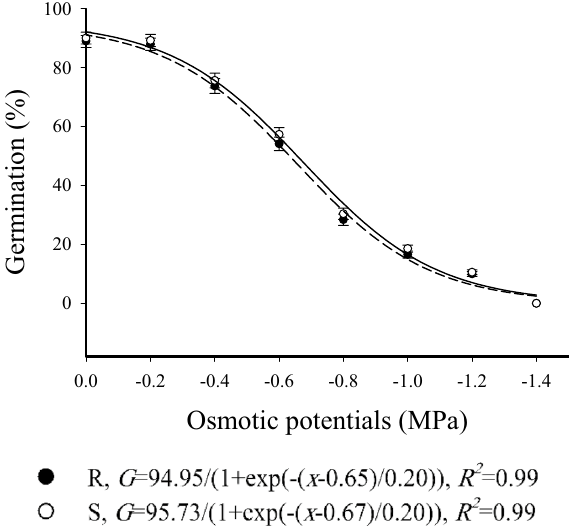
Figure 2. Germination of herbicide-resistant (black circles) and -susceptible (white circles) winter wild oat biotype as affected by different osmotic potentials. The data was fit with a three parameter sigmoidal function using SigmaPlot Version 12.5, from Systat Software, Inc., San Jose California USA, www.systa tsoft ware.com. The statistical analysis was performed using SAS Version 9 software (SAS Institute Inc., Cary, NC, USA).